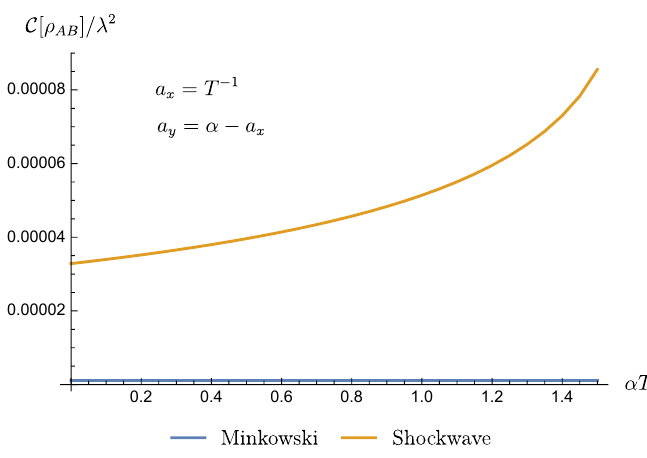
Figure 5 . Concurrence as a function of α = Tr( A ) . By fixing a x T (here we set a x T = 1 for concreteness), the trace characterizes the relative magnitude of a y . Here we set Ω T = 3 . 75 , and have the detectors fixed at z A = − 2 T and z B = 2 T . Note that from figure 4 we know that the detectors do not encounter the shockwave during their switched-on